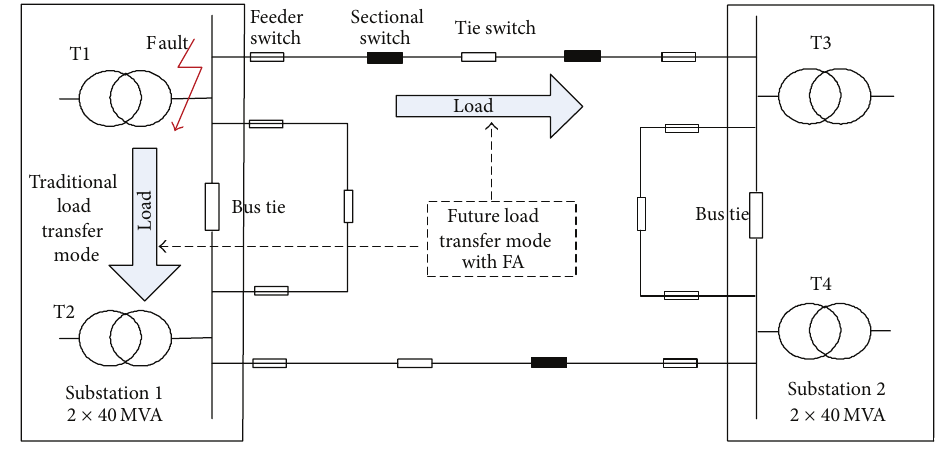
Figure 1: Load transfer